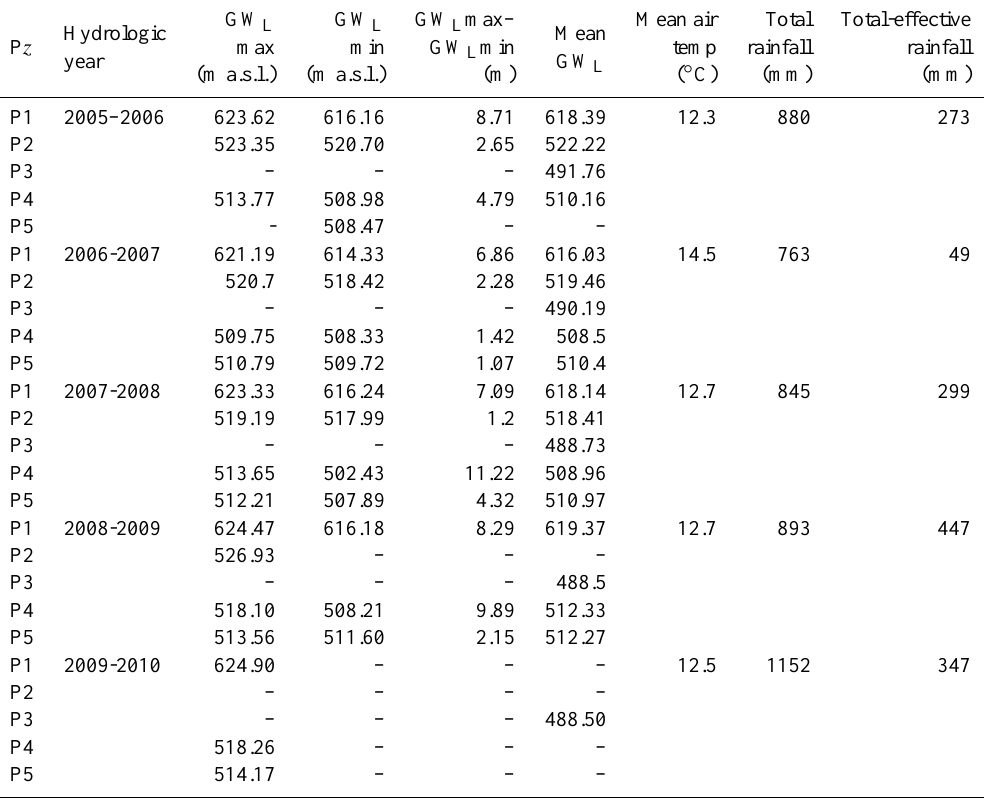
Table 2. Piezometer monitoring results and total-effective rainfall. Data are distinguished by hydrologic year.